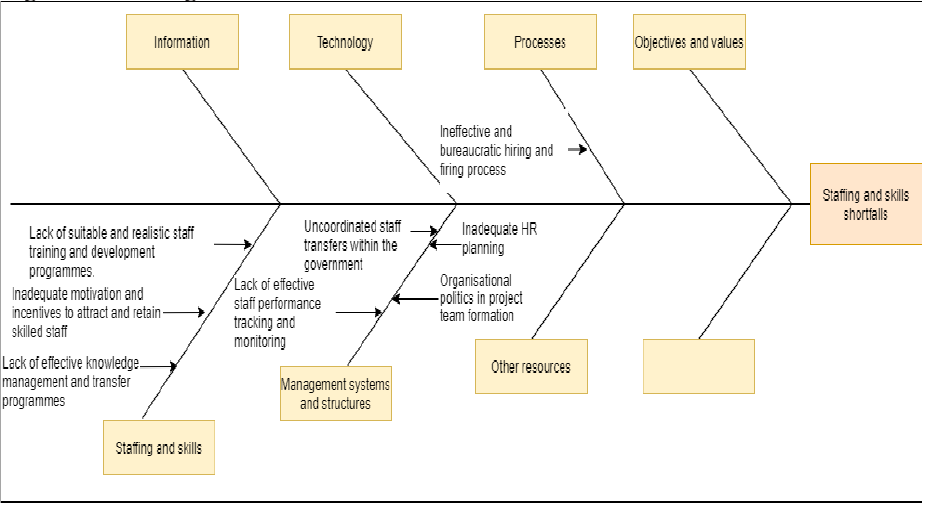
Figure 13: Staffing and skills shortfalls